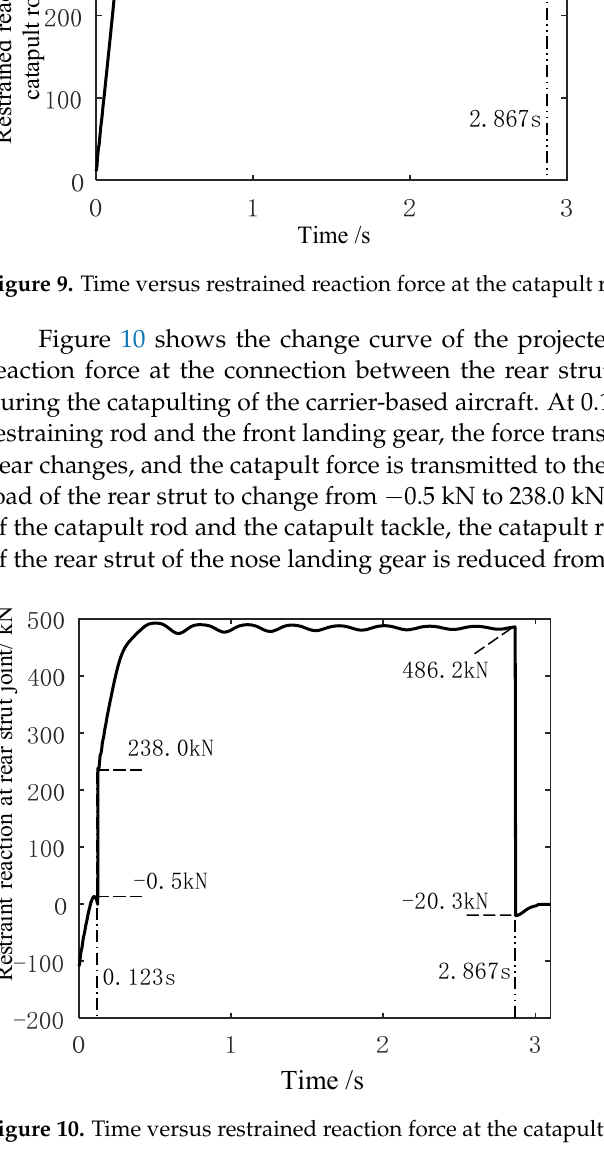
Figure 8. Time versus restraint reaction force at the pin joint.